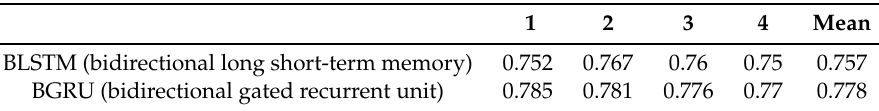
Table 7. The accuracy of four experiments of two models.